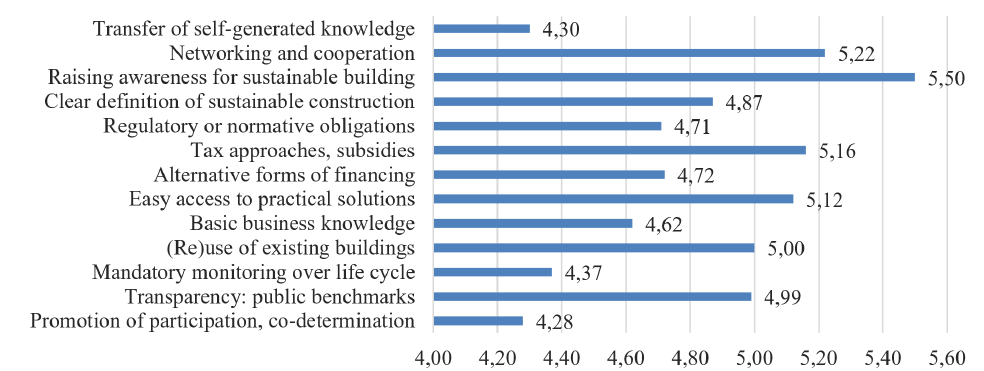
Figure 5. Effective strategies (quoted from 1 to 6, where 1 means not applicable at all and 6 fully applicable, and starting by